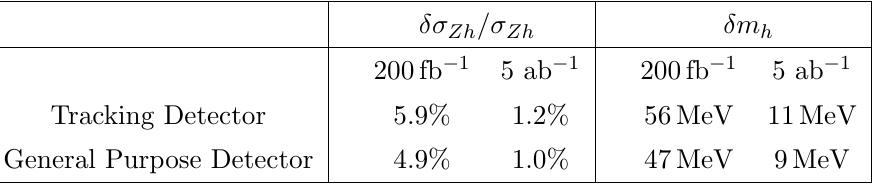
Table 1 . Projected statistical uncertainties that can be achieved at a 250 GeV e + e (cid:0) collider for the Zh inclusive cross section and Higgs boson mass using the di-muon recoil method with either a single tracking detector or general purpose detector with 200 fb (cid:0) 1 or 5 ab (cid:0) 1 of integrated luminosity. The moderate reduction in uncertainties for these important Higgs boson measurements with a general purpose detector that allows for a veto on hard ISR photons which reduces 2 f backgrounds,